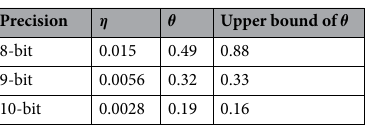
Table 4. Normalized errors of 8-bit, 9-bit, and 10-bit Richardson